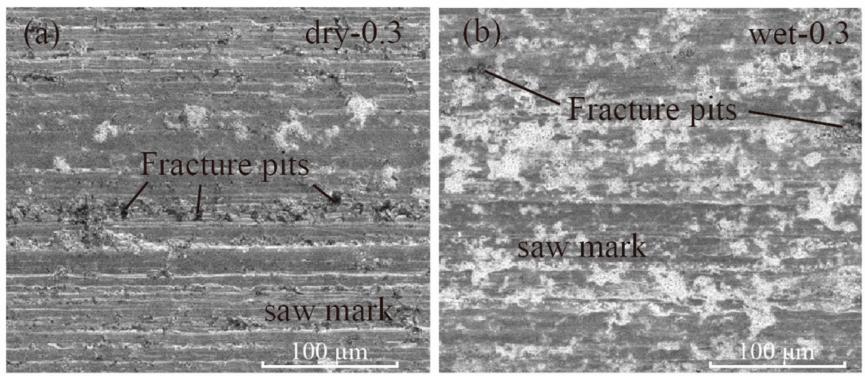
Figure 11. SEM images for ( a ) dry cutting and ( b ) wet cutting with a 0.3 mm/min feed speed. As for the influence of the feed speed, the surface was much rougher when the feed speed was larger. Even though the surface roughness Ra along the saw direction was slightly higher for the 0.05 group than for the 0.1 feed rate group, the surface morphology under SEM for these two groups was very different as shown in Figure 12. As shown in Figure 12, more cracks and fracture pits could be found under the microscope for the 0.05 group. However, the surface for the 0.1 mm/min group was flatter with more ductile removal marks. It can be seen from Figure 12c that NdFeB grains were loosened and started to fall off the surface, but for the 0.1 group, the fracture zone was smoother.